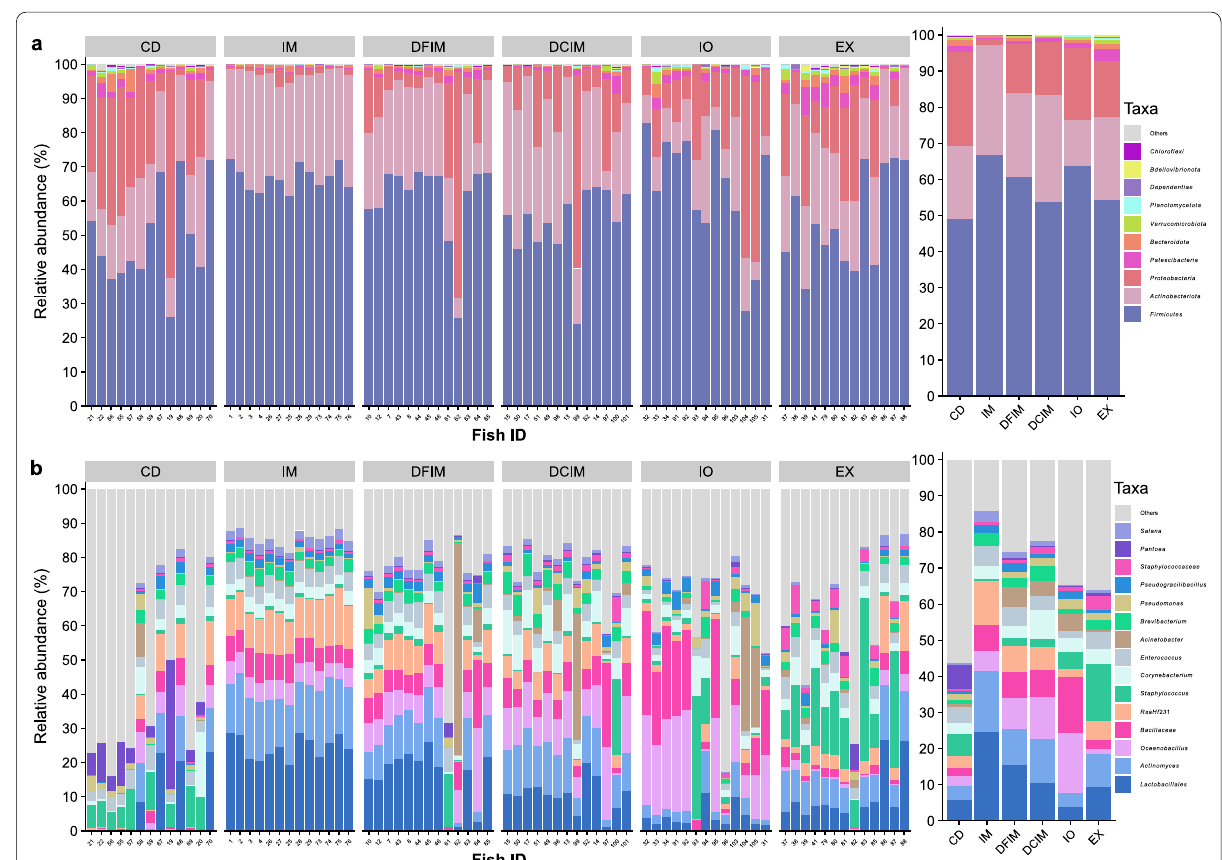
Fig. 2 Most abundant taxa in distal intestine digesta samples from fish fed experimental diets. Top 10 most abundant taxa at phylum (comprised 99.6–100% of abundance) ( a ) and top 15 most abundant taxa at genus or lowest taxonomy level (comprised 44–86% of abundance) ( b ). The plots in left side of the figure display the relative taxa abundances in all the samples. The samples are grouped by the diet. The plots in right side display the mean abundance of each taxon within the same dietary group. CD control diet; IM full-fat BSF (black soldier fly) larvae meal diet; DFIM defatted BSF larvae meal diet; DCIM de-chitinized BSF larvae meal diet; IO BSF larvae oil diet; EX BSF larvae exoskeleton